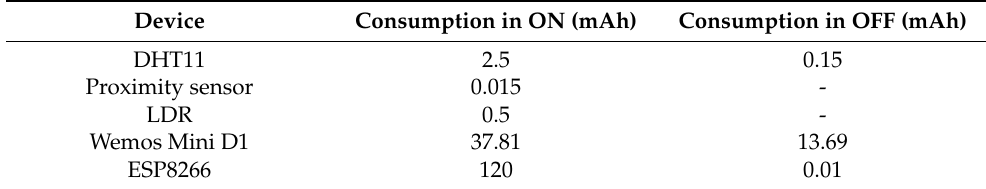
Table 3. Consumption for each device.